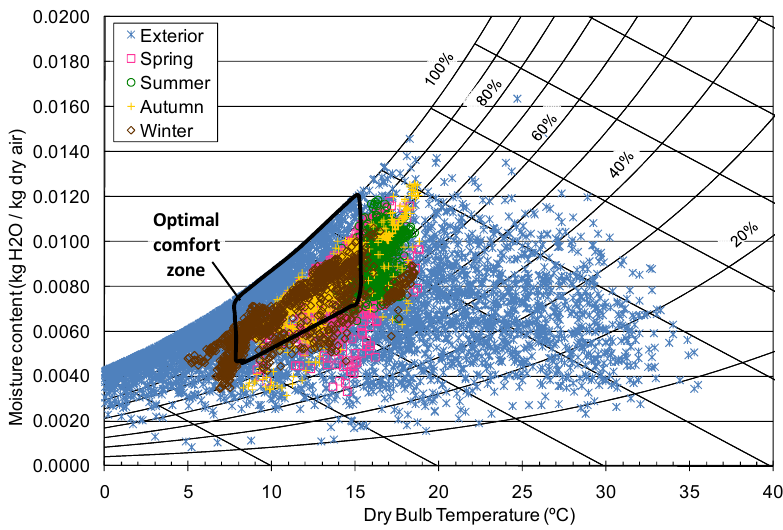
Figure 7. Indoor and outdoor hygrothermal conditions of the aboveground with air-conditioning construction. Four daily values represented (00:00, 6:00, 12:00 and 18:00) over the 2006–2009 period.